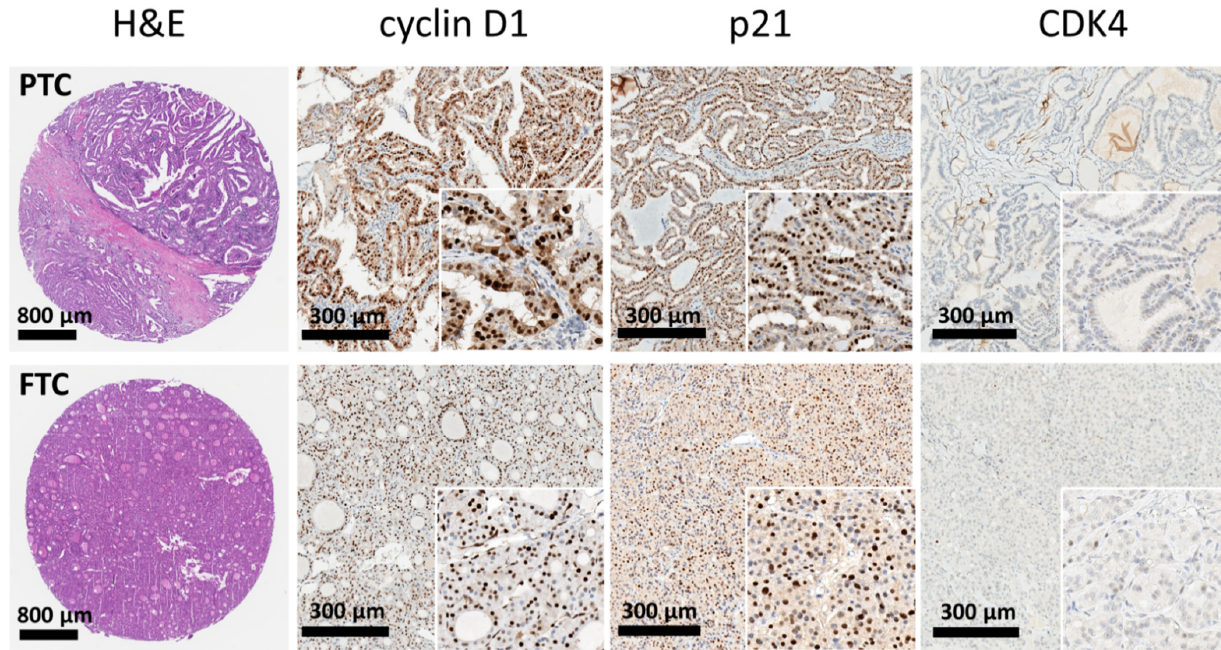
Figure 1. Representative images and distribution of the investigative markers. The microarray cores exhibited features of papillary carcinoma (upper panels) and follicular carcinoma (lower panels). The cores of thyroid cancer tissue showed strong expression of cyclin D1 and p21, while loss of expression of CDK4.